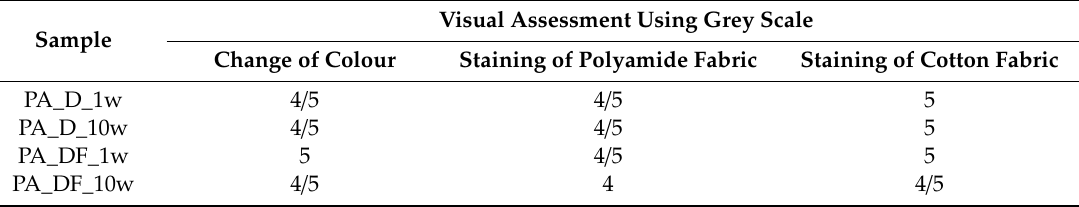
Table 3. Visual assessment of colour fastness of tested samples to